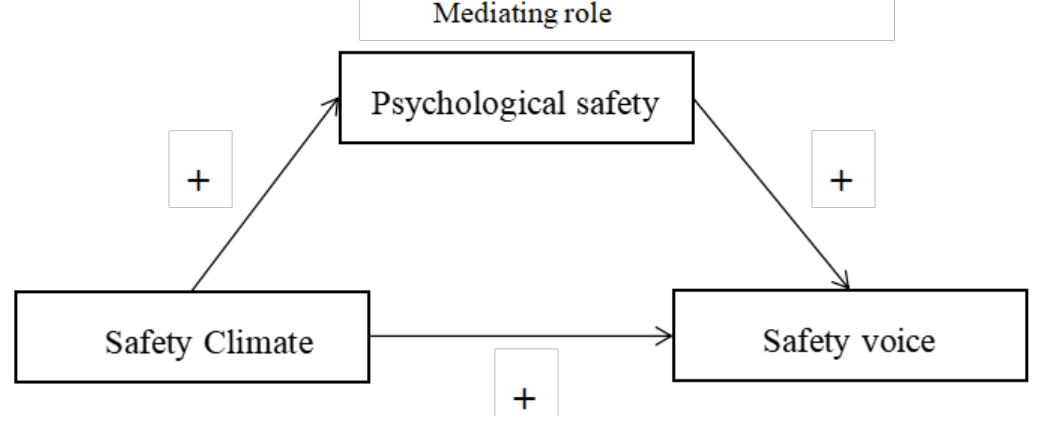
Figure 1. Research hypothesis model.